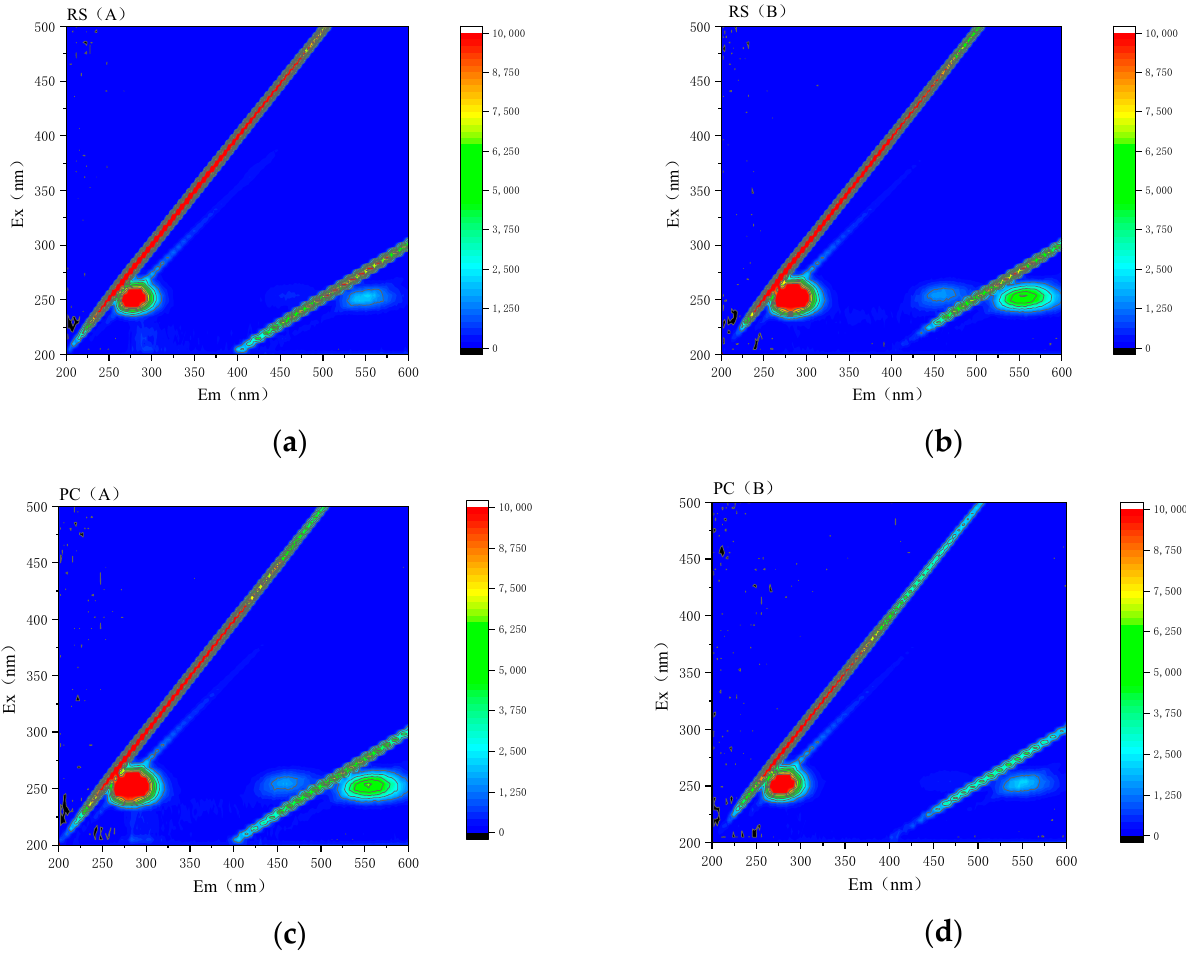
Figure 6. ( a ) Raw sediment A extract; ( b ) Raw sediment B extract; ( c ) Solidified sediment A extract; and ( d ) Solidified sediment B extract.